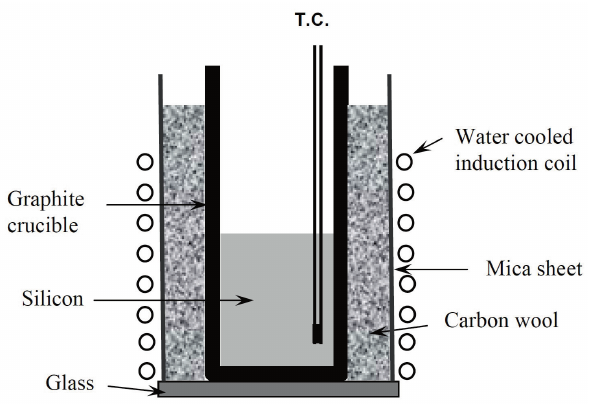
Figure 1. Schematic of the experimental set